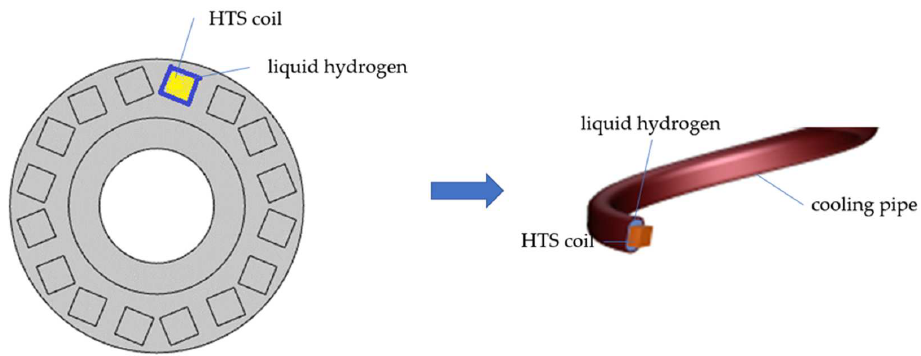
Figure 8. The cooling system. Each HTS coil was housed in a modular pipe and cooled by circulating liquid hydrogen. All pipes eventually connected to the same liquid hydrogen storage tank.